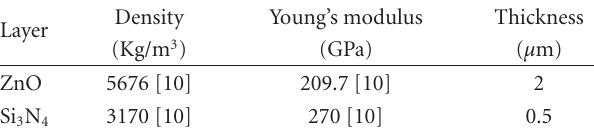
Table 1: Geometric and material data of the T-shaped piezoelectric ZnO cantilever.